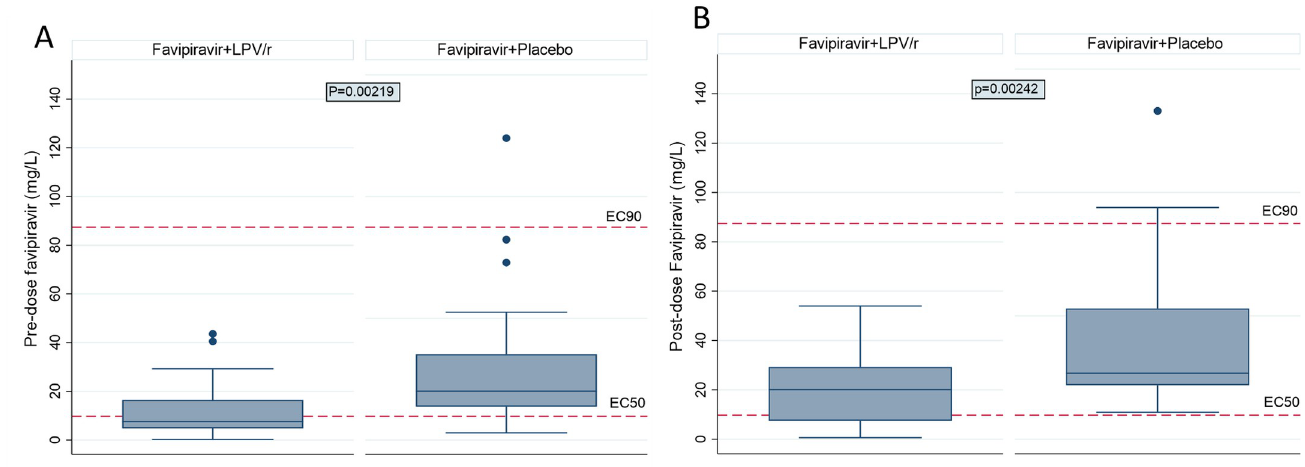
Fig 4. Plasma favipiravir concentration in the combination favipiravir+lopinavir-ritonavir (LPV/r) arm and the favipiravir+placebo arm on Day 7 (A) pre-dose (trough) and (B) 30–60 minutes post-dose (peak). Boxes represent IQR and whiskers represent 1.5 � IQR. EC50: half maximal effective concentration. EC90, 90% maximal effective concentration. IQR, interquartile